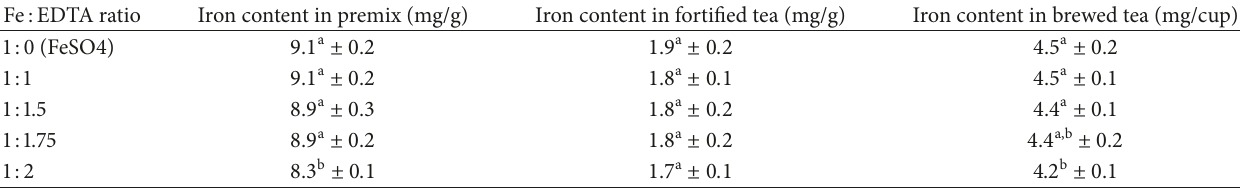
Table 1: Iron content in premix (target 10 mg/g), fortified tea (target 2 mg/g), and brewed tea (5 mg/cup).